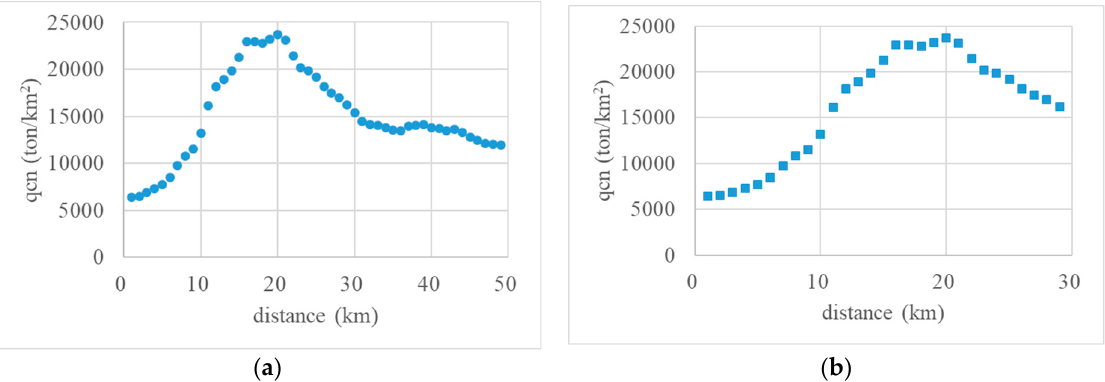
Figure 7. Statistical results for individual layers in Nanjing. ( a ) Whole urban area; ( b ) Central urban area.